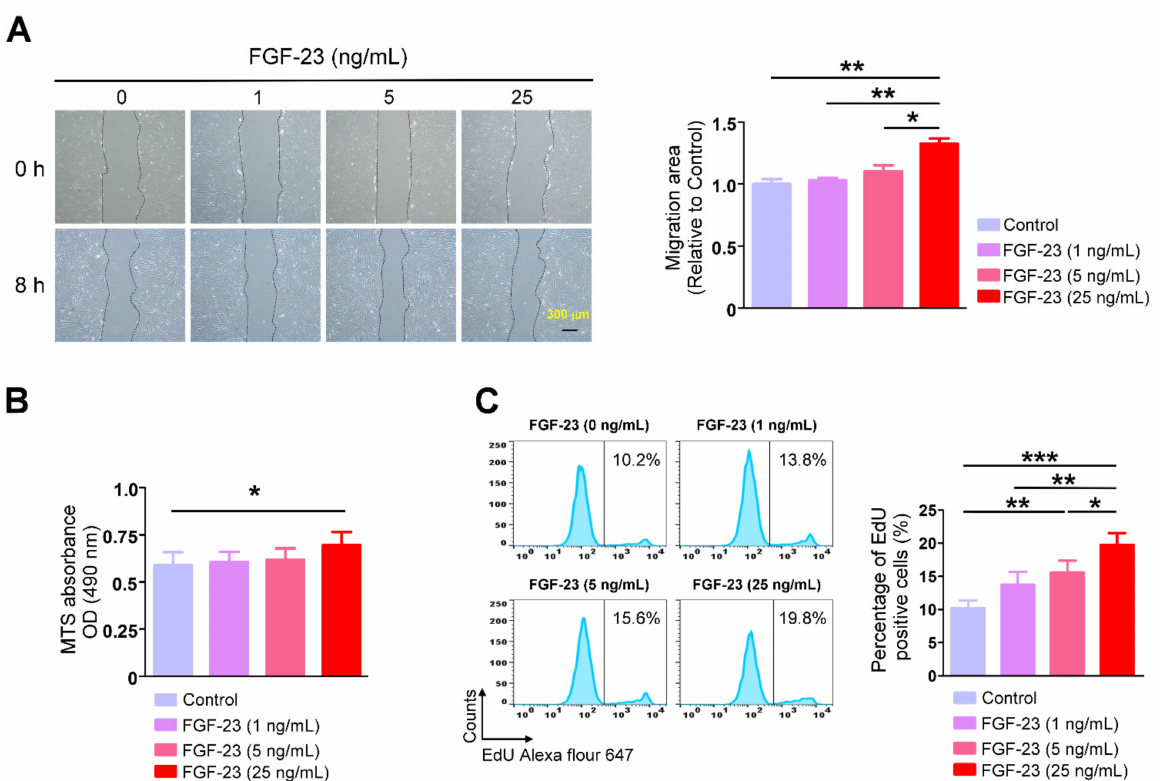
Figure 1. Cardiac fibroblast migration and proliferation in control and fibroblast growth factor (FGF)-23-treated human atrial fibroblasts. ( A ) Representative images (left panel) and average data (right panel, n = 5) of the migration assay of cardiac fibroblasts. Confluent cells were scratched 8 h before the endpoint of treatments, and images were taken at 0 h and 8 h post wound from control and FGF-23 (1, 5 and 25 ng/mL)-treated cardiac fibroblasts. Scale bar represents 300 µ m. ( B ) Average data of cell proliferation analysis with the MTS reagent ( n = 5). The optical density (OD) value was measured at a wavelength of 490 nm in cardiac fibroblasts treated without and with FGF-23 (1, 5 and 25 ng/mL) for 48 h. ( C ) Representative images (left panel), average data and statistical differences (right panel, n = 5) of an 5-ethynyl-2 (cid:48) -deoxyuridine (EdU)-based flow cytometry assay to evaluate cell proliferation in control and FGF-23 (1, 5 and 25 ng/mL)-treated cardiac fibroblasts. * p < 0.05, ** p < 0.01, *** p <